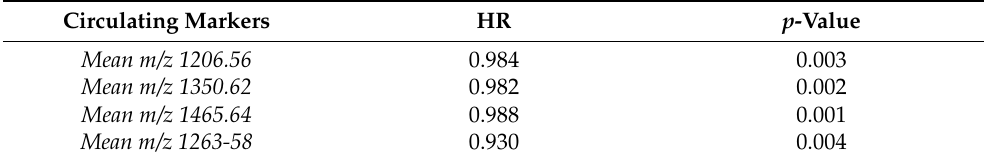
Table 6. Coefficients and relative p -values of the univariate Cox regression model using 4 peptides. Circulating Markers HR p